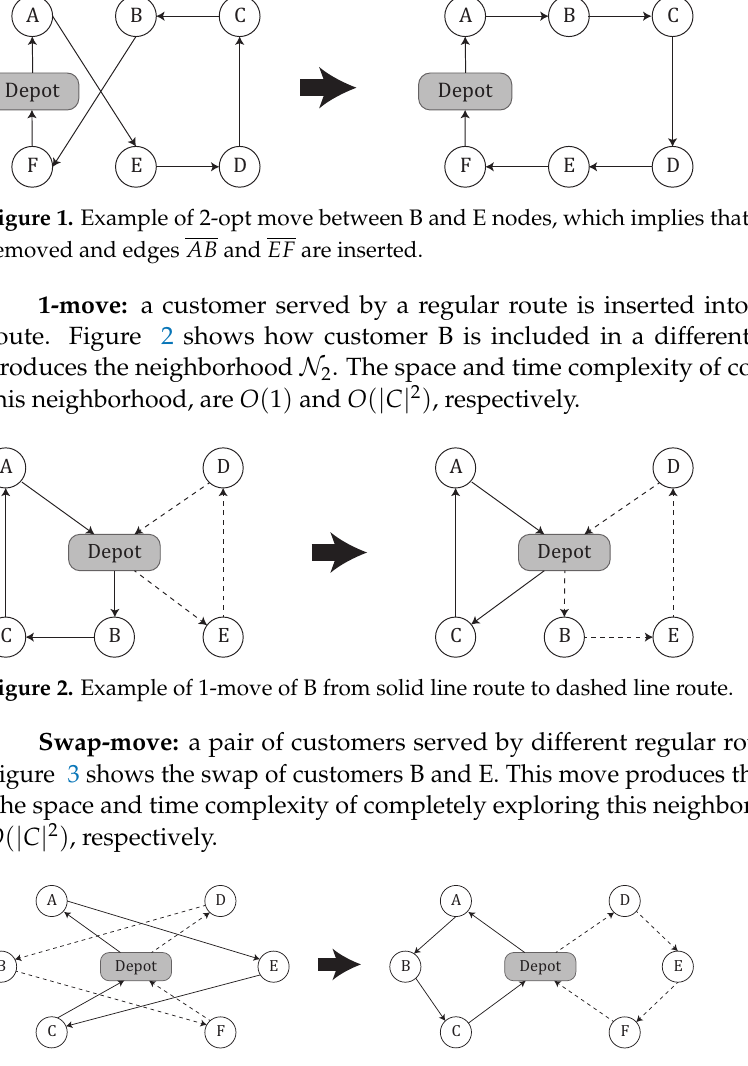
Figure 3. Example of swap move between B and E